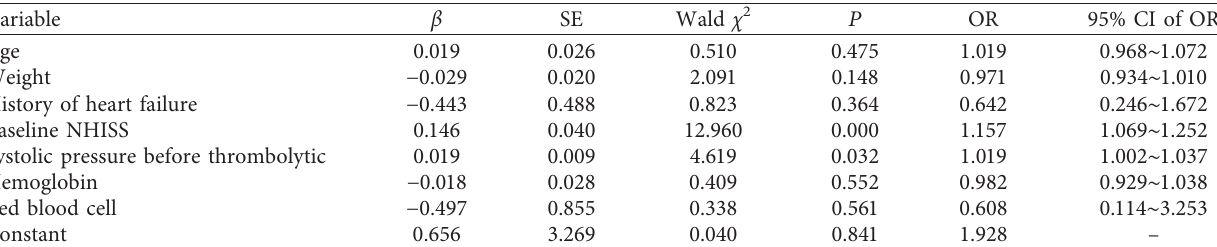
Red blood cell Table 5: Binary logistic regression analysis of the influence on intravenous thrombolysis of alteplase in ICS patients with atrial fibrillation.